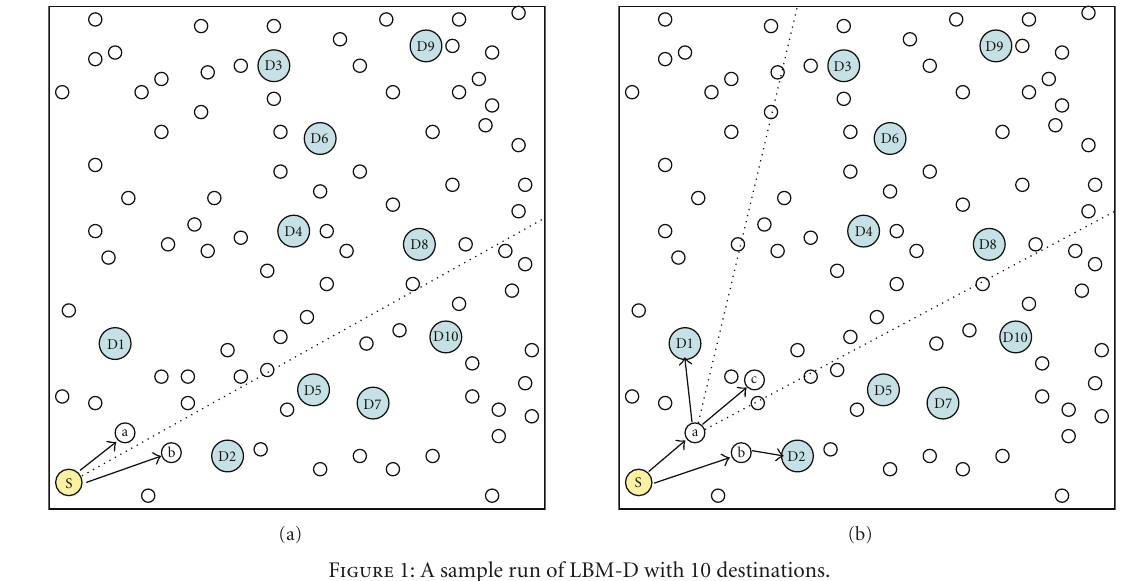
Figure 1: A sample run of LBM-D with 10 destinations.